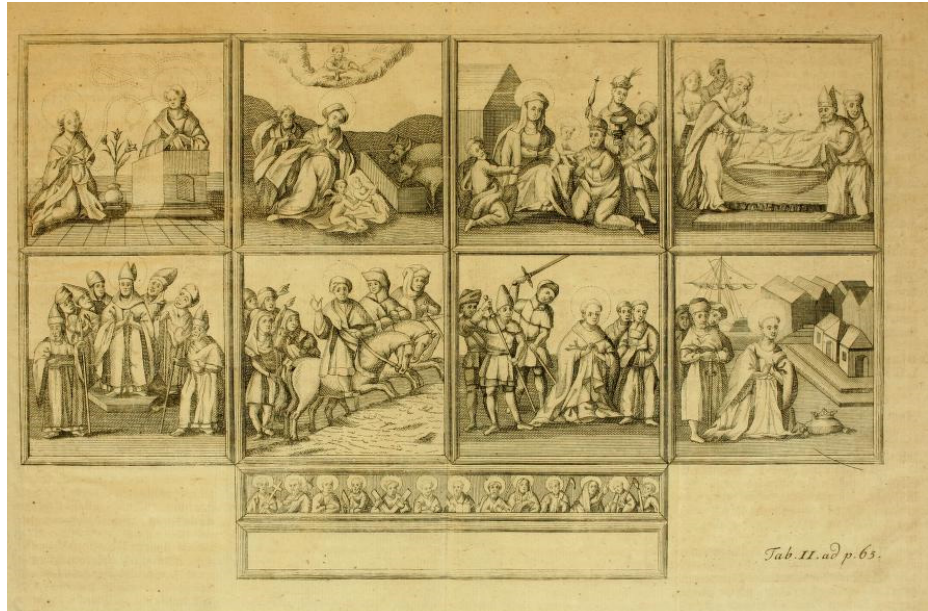
Figure 3. Thomasaltar , engraving showing lost wing panels published in Nicholas Staphorst’s Ham- burgischen Kirchen-Geschichte , 1731. Photo: courtesy of the Boston Public Library. burgischen Kirchen-Geschichte , 1731. Photo: courtesy of the Boston Public